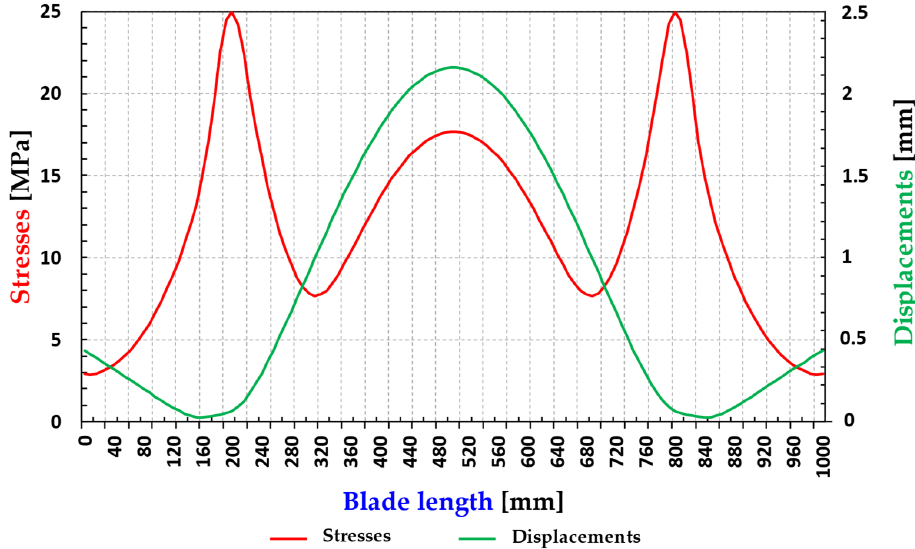
Figure 21. Maximum values of the stresses and displacements at the point of application of maximum loads (c/4) of rotor blade 1 made of V-Epoxy with the optimum thickness of 5 mm.